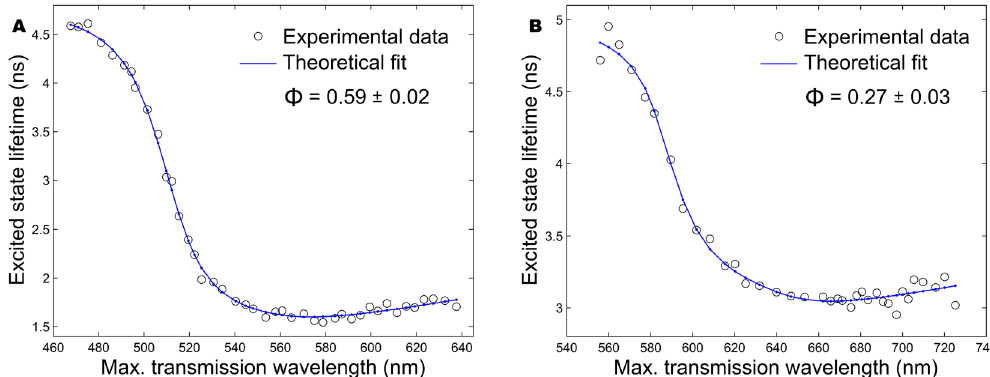
Figure 13. Nanocavity-modulated excited state lifetime of green ( A ) and red ( B ) forms of SAASoti V127T protein in 6 μ M aqueous solution as a function of the maximum transmission wavelength of the cavity. Black circles are the measured data; blue curves are fits of the model. Φ indicates the values of the quantum